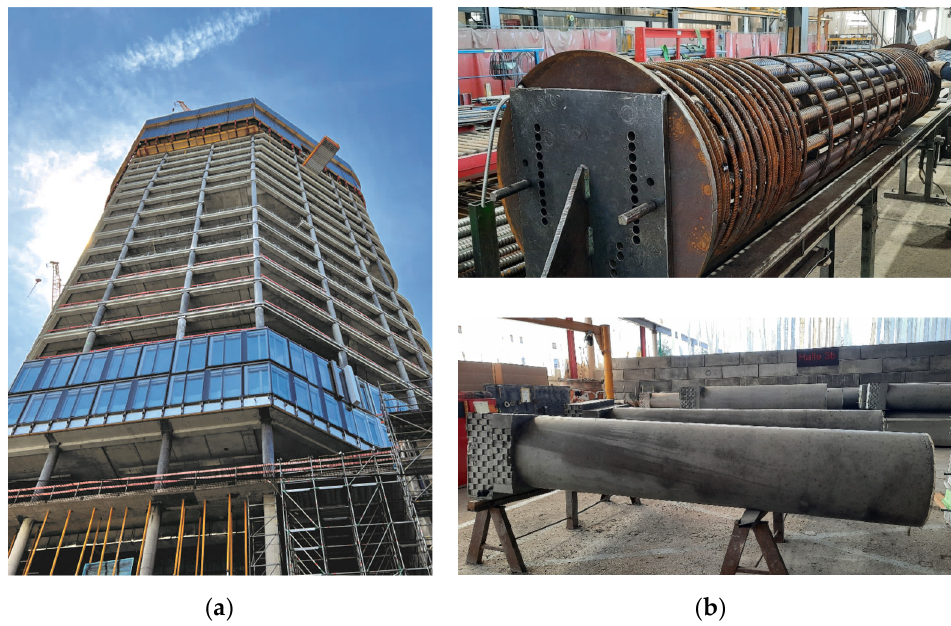
Figure 1. FOUR high-rise project in Frankfurt: ( a ) precast columns installed in high-rise structure; ( b ) reinforcement cage and finished column at SACAC AG in Lenzburg, Switzerland [9].